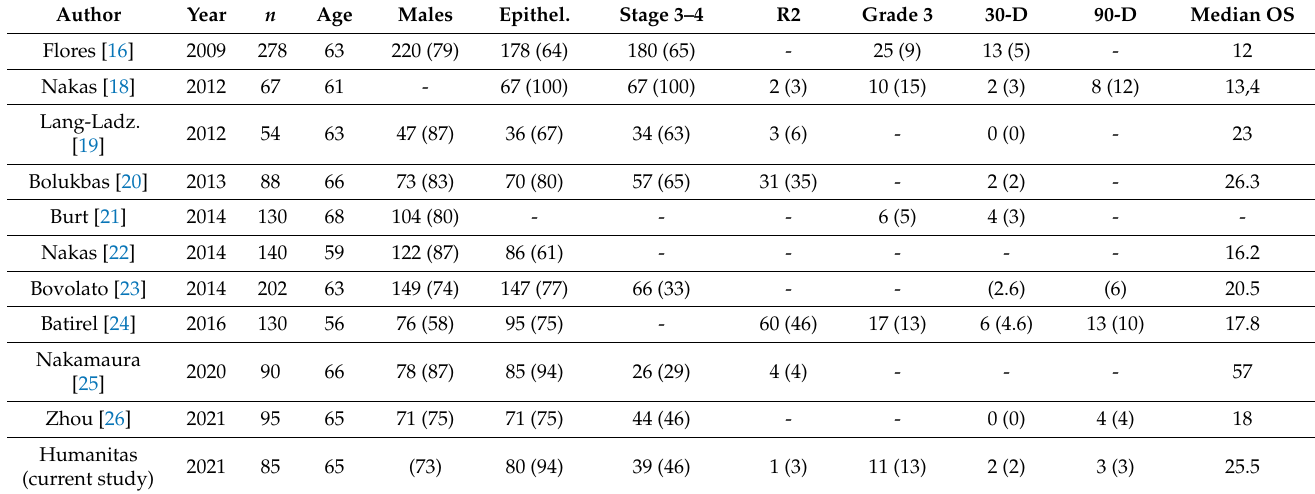
Table 5. Postoperative complications, mortality, and outcomes after